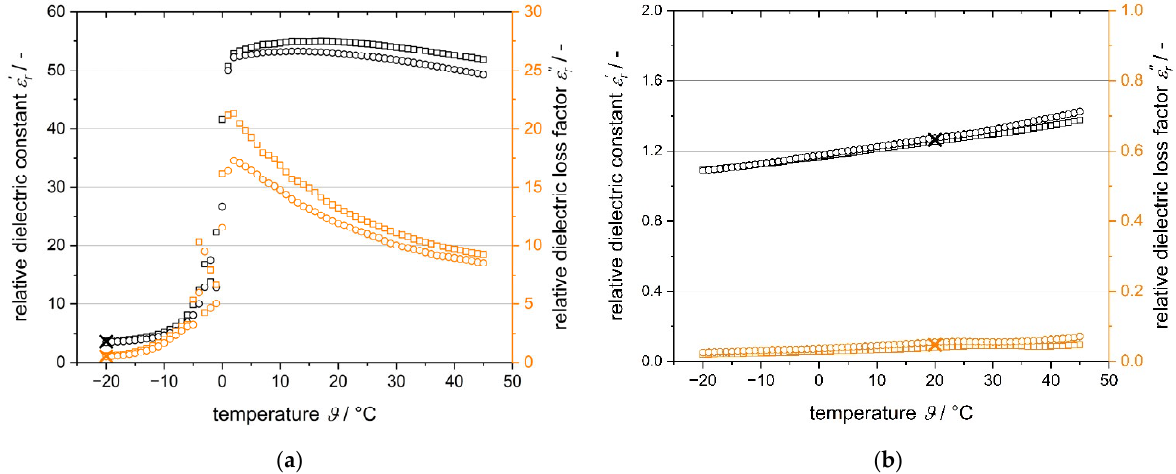
Figure 4. ( a ) Dielectric properties of fresh tylose gel; ( b ) Dielectric properties of freeze-dried tylose gel. The results were obtained in duplicate. The arithmetic means of the dielectric properties utilized in the simulations are marked with an x.